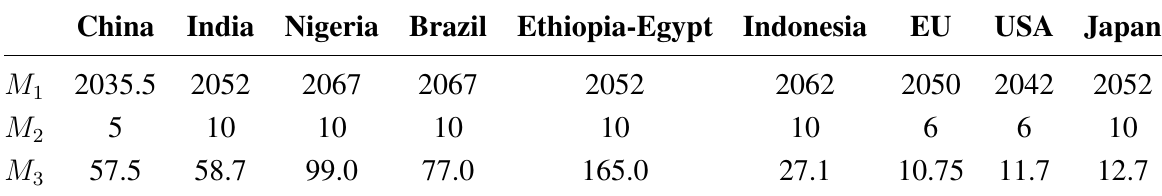
Table 7. High nuclear case multiplier